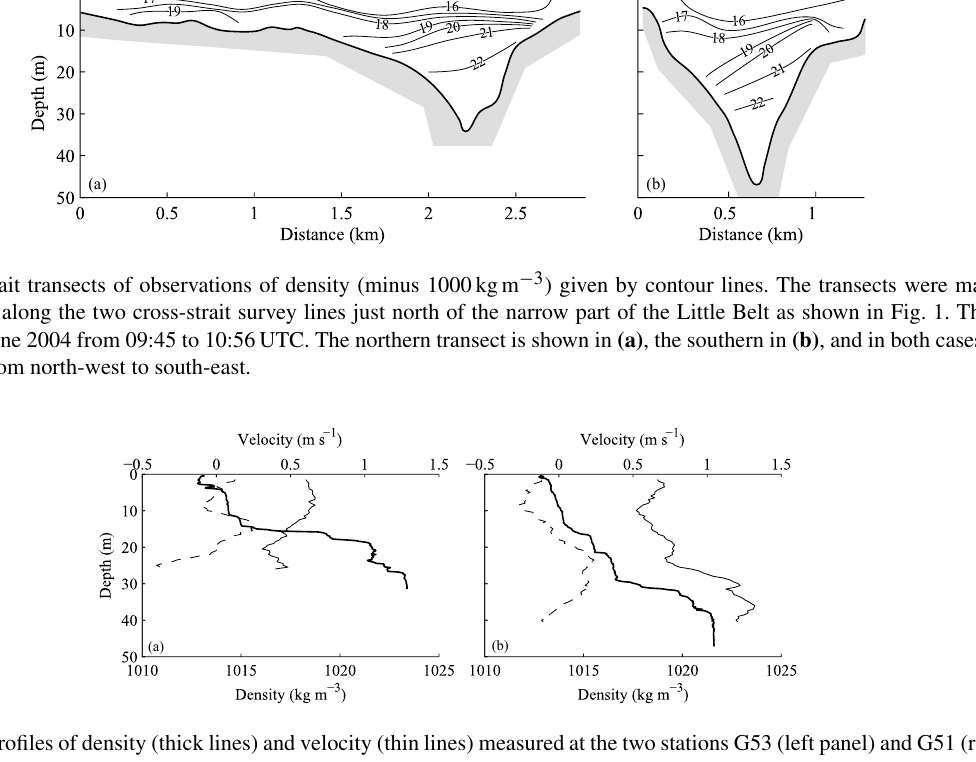
Figure 6. Vertical profiles of density (thick lines) and velocity (thin lines) measured at the two stations G53 (left panel) and G51 (right panel), shown in Fig. 1. The observations were made on 11 May 2004 at 19:10 and 18:20UTC, respectively. The velocity is projected onto the main flow direction (solid line; positive southward through the Little Belt) and perpendicular to this (dashed line; positive to the right of the main flow